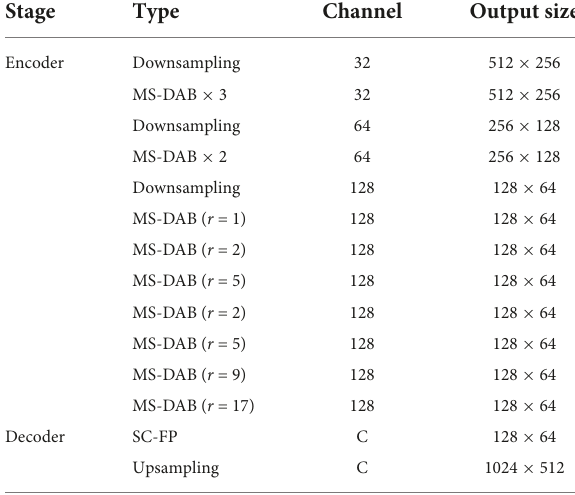
TABLE 1 The detailed architecture of lightweight multi-dimensional dynamic convolutional network